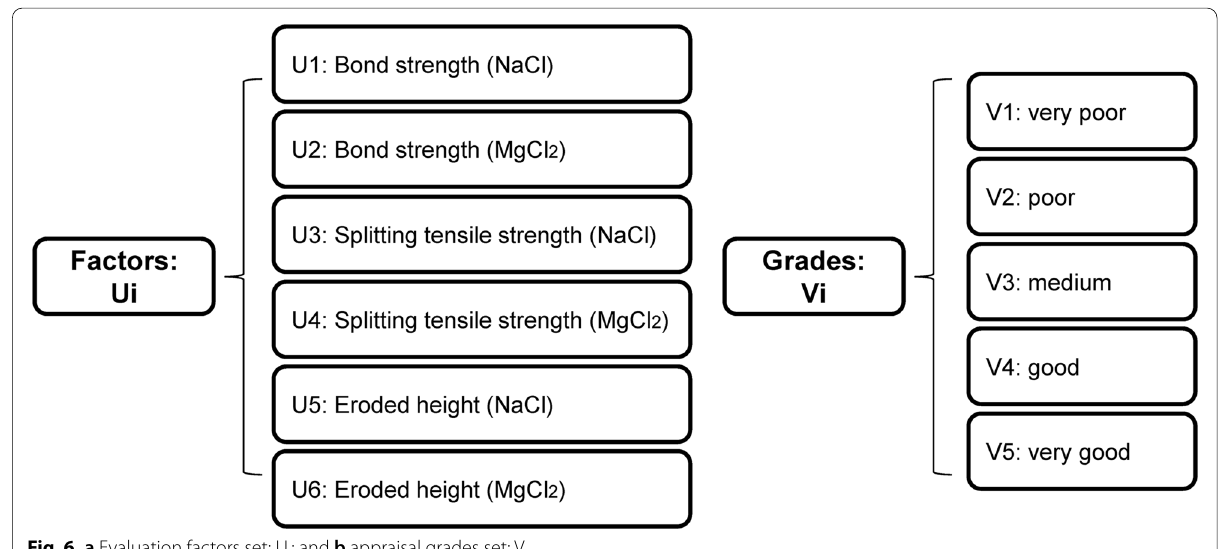
Fig. 6 a Evaluation factors set: U i ; and b appraisal grades set: V i